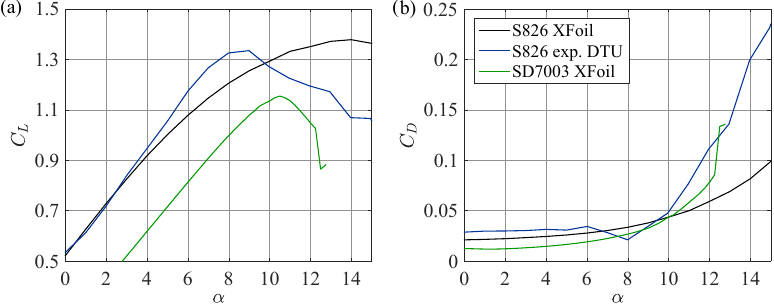
Figure 2. (a) Lift coefficient and (b) drag coefficient for Re = 1 . 0 × 10 5 for NREL S826 from XFoil, NREL S826 from experiments DTU, and SD7003 from XFoil.